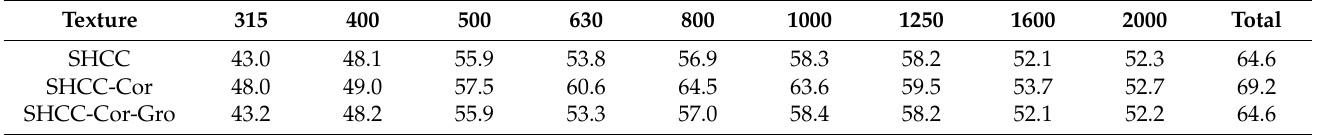
Table 10. Sound level (total) for SHCC, modified SHCC-Cor, and